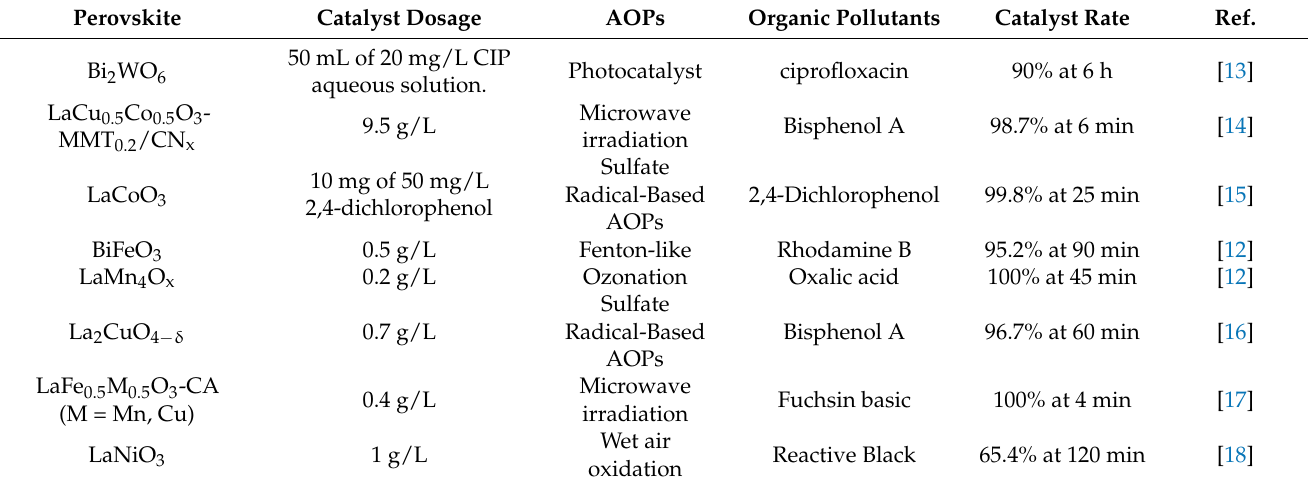
Table 1. The following was the introduction of perovskite and the role of OVs. Table 1. Types of perovskites and the catalyst rate in